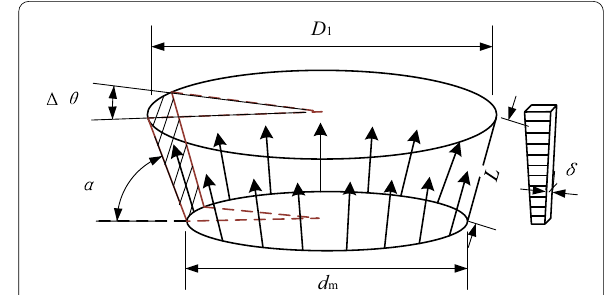
Figure 3 The parameter model of the rubber